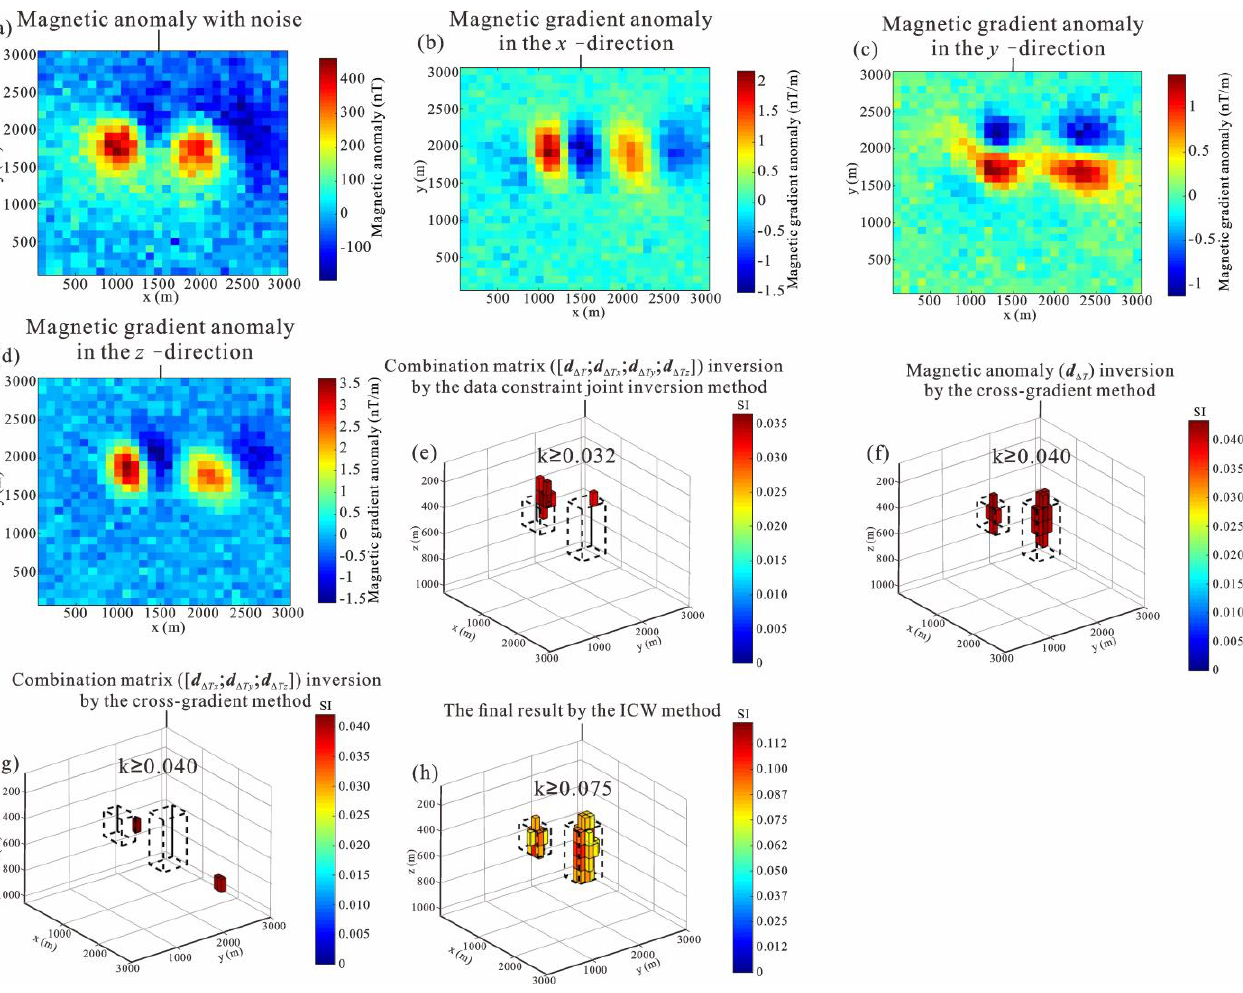
Figure 8. Magnetic and gradient anomalies with Gaussian noise and volume – rendered images by different inversion methods. ( a – d ) Noise – corrupted magnetic and gradient anomalies with Gaussian noise of a signal – to – noise ratio of 10. ( e ) Volume – rendered image of combination matrix ( [ d ∆ T ; d ∆ T ; d ∆ T ; d ∆ T ] ) inversion by the data constraint joint inversion method. ( f ) volume-rendered image of magnetic anomaly ( d ∆ T ) inversion by the cross-gradient method. ( g ) volume-rendered image of the combination matrix ( [ d ∆ T ; d ∆ Tx ; d ∆ T ) inversion by the cross – gradient method. ( h ) Volume – rendered image of the final result by the ICW method.